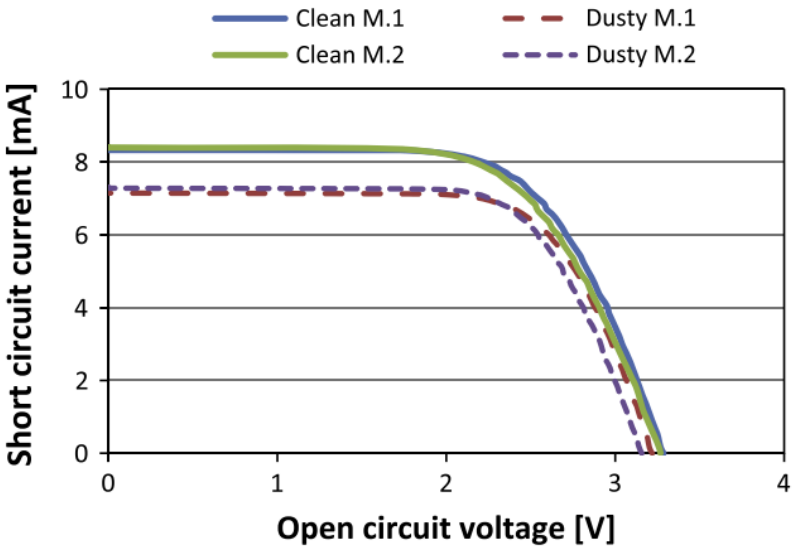
Figure 8. At noon, the I-V curves of the dusty and clean modules. Reprinted from Solar Energy, 107, Said, Syed A.M. et al., Fundamental studies on dust fouling effects on PV module performance, 332., Copyright (2014), with permission from Elsevier [59].